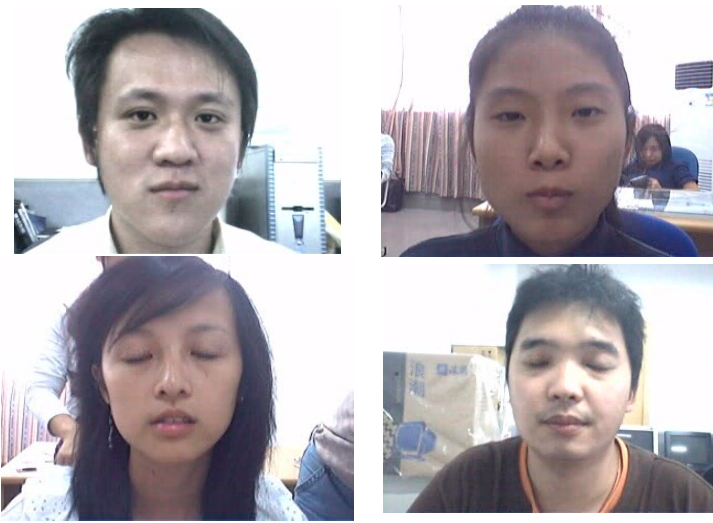
Figure 4. Sample images from DB2.